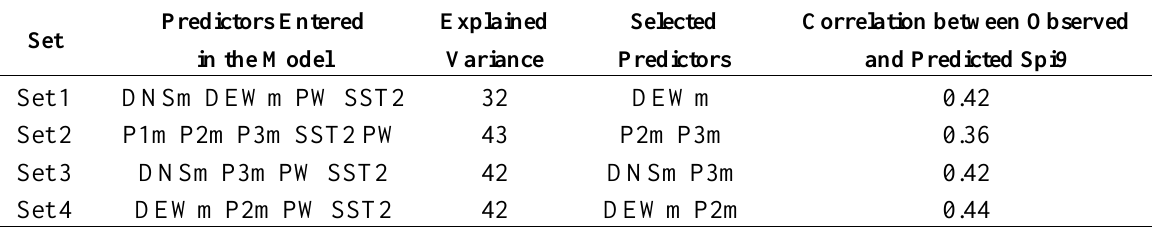
Table 3. Sets of predictors used in linear regression model.